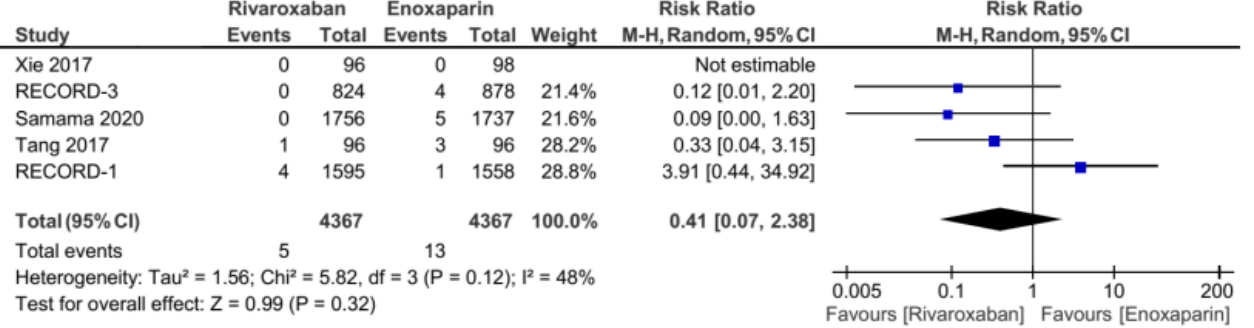
Figure 4. Incidence of proximal DVT [5,7,13,14].